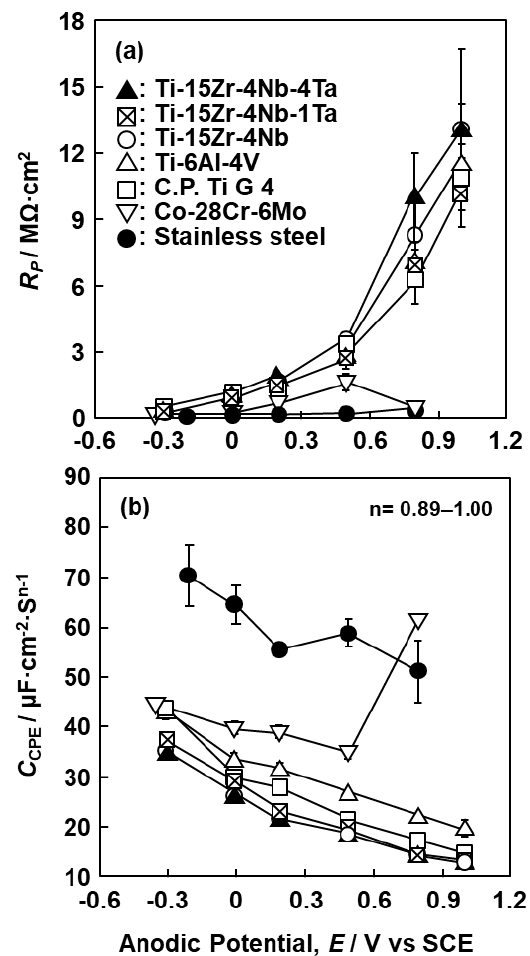
Figure 11. ( a ) Resistance of oxide film (R P ) and ( b ) capacitance of oxide film (C CPE ) formed on surfaces of Ti–15Zr–4Nb–(0 to 4)Ta and Ti–6Al–4V alloys after anodic polarization at various potentials in 0.9% NaCl solution at 37 °C.